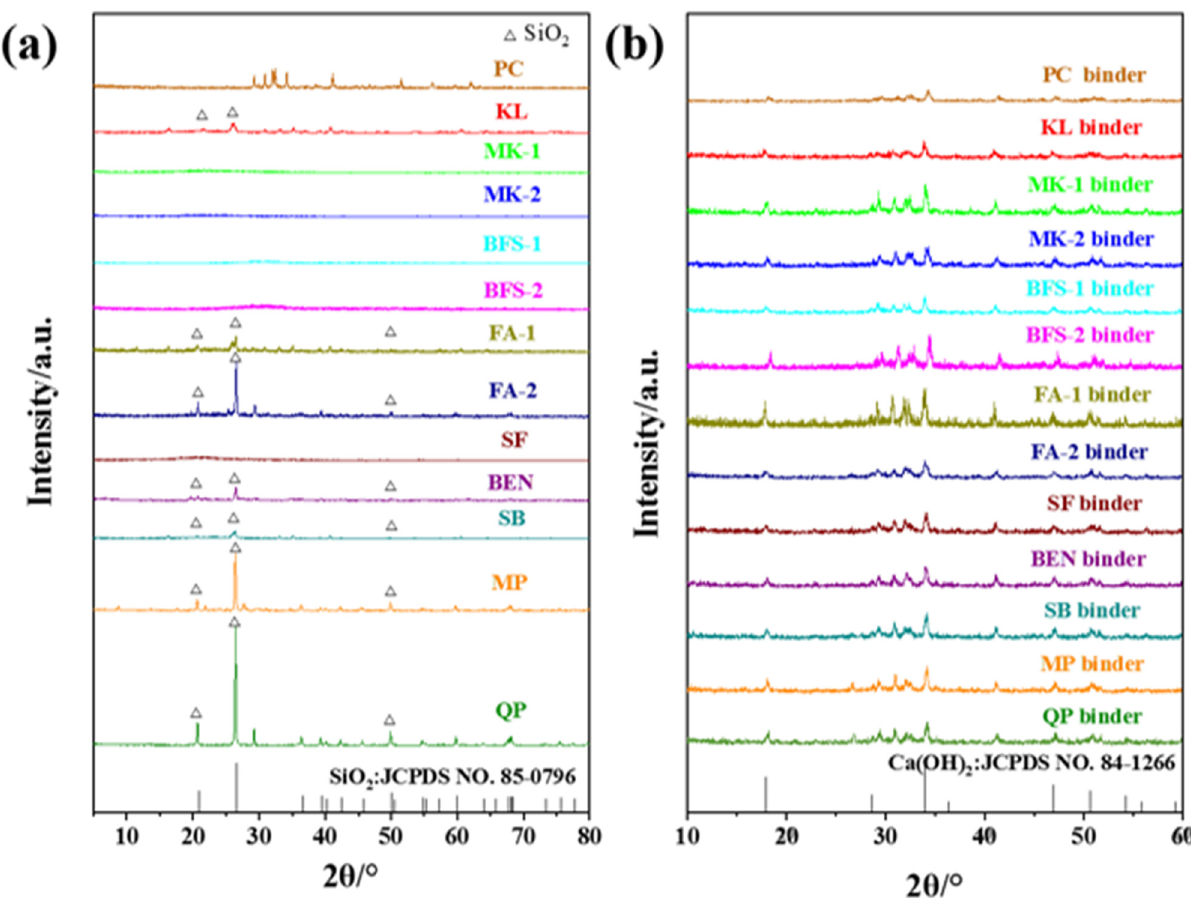
Figure 5: The XRD patterns of materials: ( a ) raw materials and ( b ) inorganic binders after curing for 7